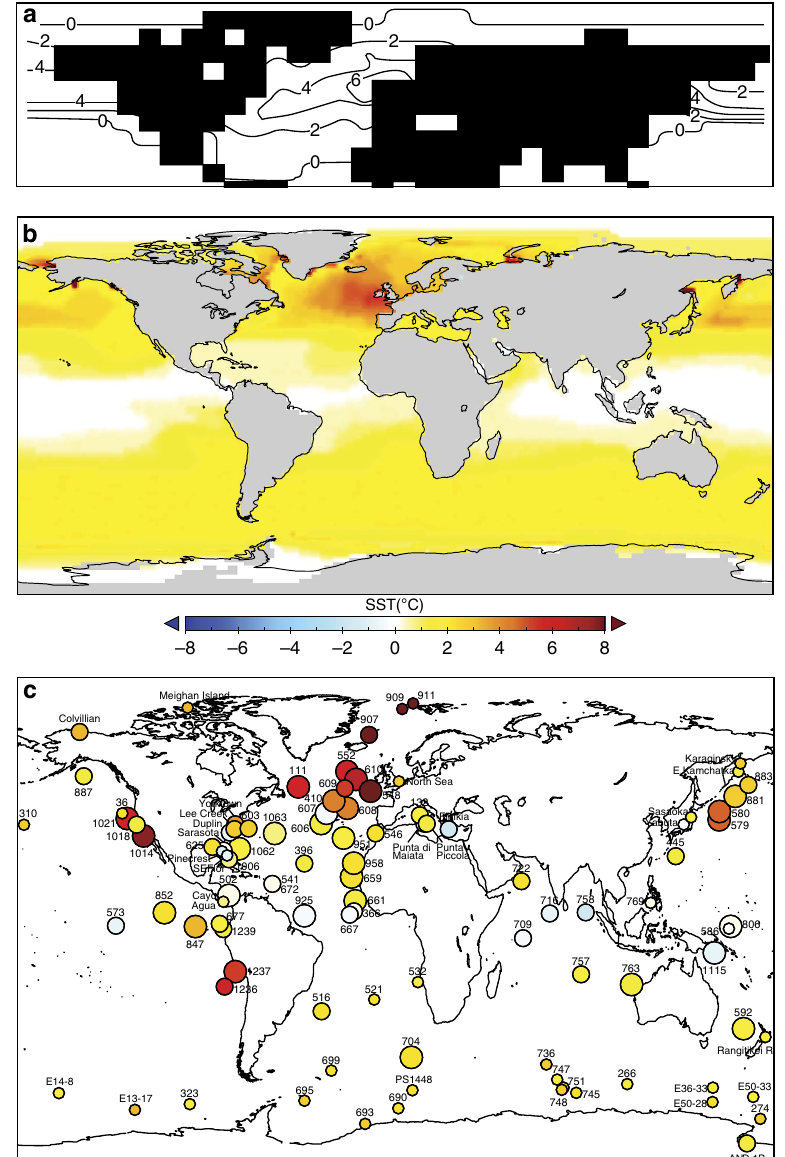
Figure 3 | Evolution of the PRISM reconstruction. The PRISM mean annual SST anomalies. ( a ) PRISM0 Northern Hemisphere reconstruction 112 . ( b ) PRISM2 global reconstruction 20,21 . ( c ) PRISM3 confidence-assessed global reconstruction where larger diameter circles represent higher confidence levels; numbers designate sample localities 9,17,57 . SST anomaly colour scale the same for b , c